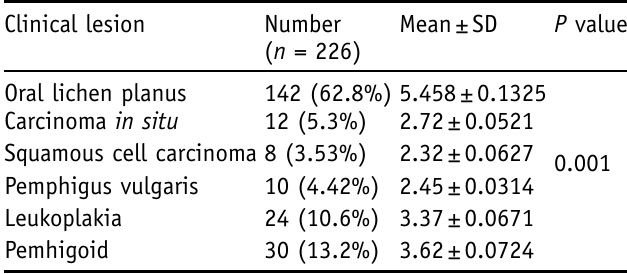
Table III. Clinical presentation of